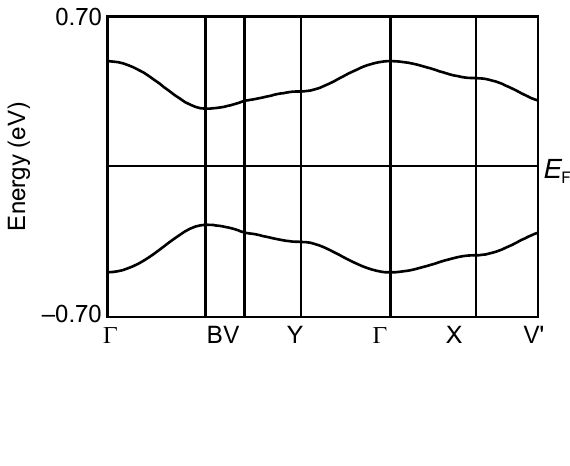
Figure 21. Calculated energy band dispersion of 7